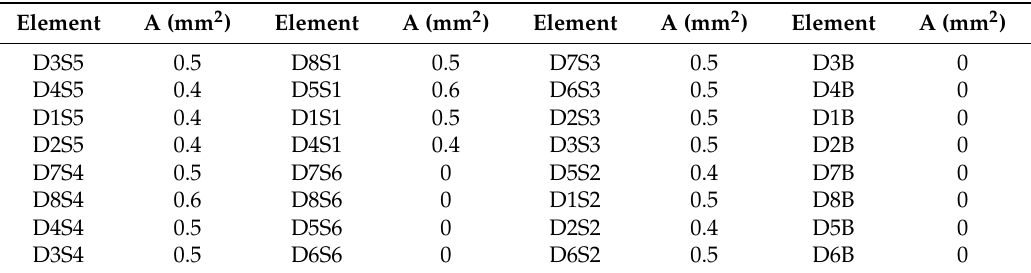
Table 2. Strut element radius represents the optimization result of the ground structure.